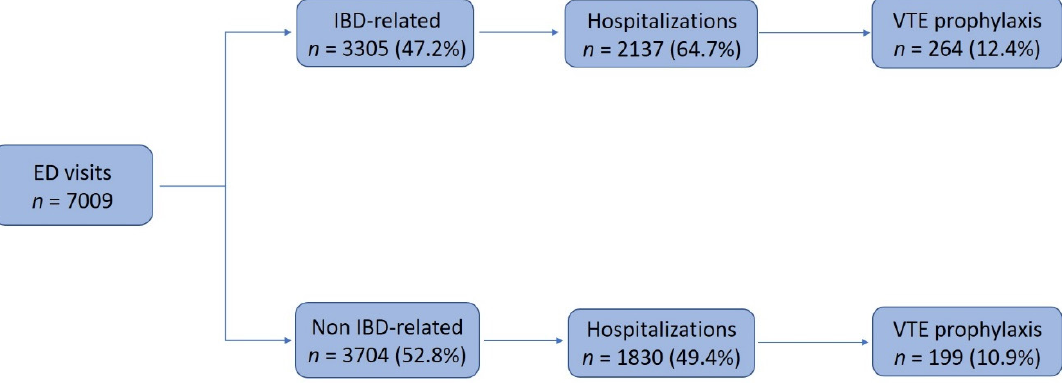
Figure 1. Distribution of all emergency department visits to IBD-related vs. non IBD-related admissions as well as hospitalizations and thromboprophylaxis administration rates.